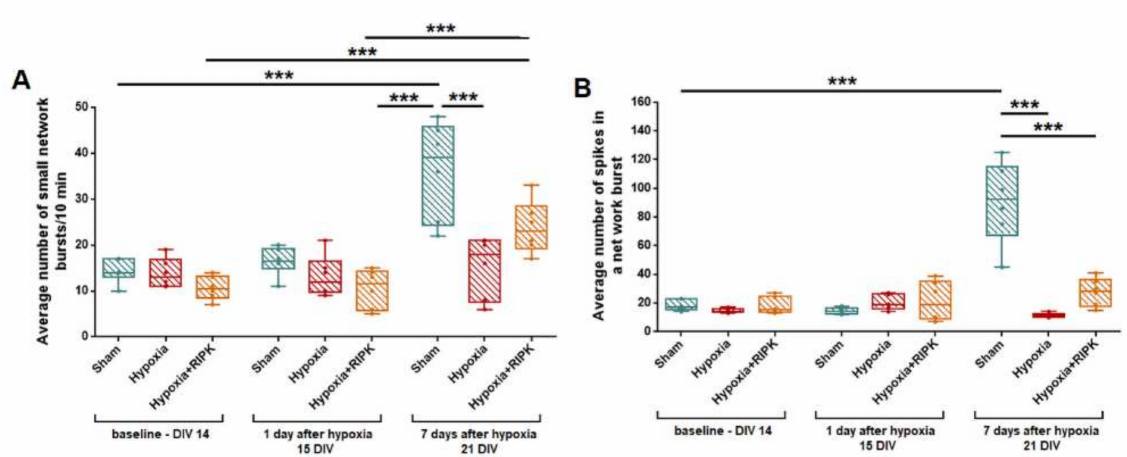
Figure 4. The main parameters of spontaneous bioelectrical activity of primary neuronal cultures associated with kinase blockade and in the modeling hypoxia in vitro. ( A )—Average number of small network bursts/10 min. DIV 14–NS, DIV 15–NS, DIV 21—F= 10.36. Sham vs. Hypoxia p = 0.001. Sham vs. Hypoxia + RIPK—NS. ( B )—Average number of spikes in a network burst. DIV 14–NS. DIV 15–NS. DIV 21–F = 34.32. Sham vs. Hypoxia p < 0.001. Sham vs. Hypoxia + RIPK—*** p ≤ 0.001. Two-way ANOVA followed by Bonferroni post-hoc test for multiple